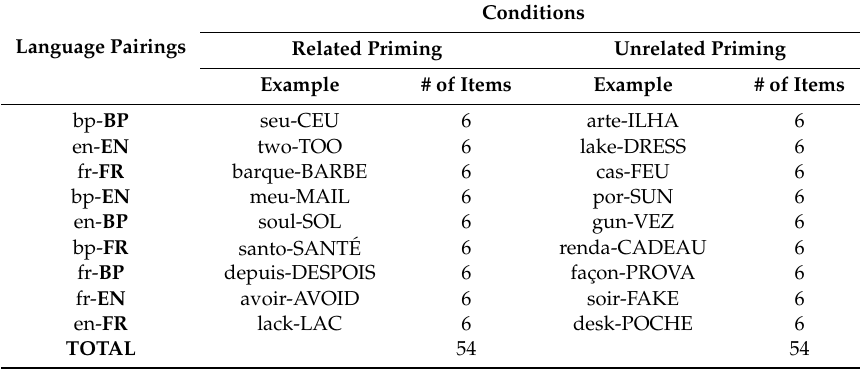
Table 2. Each sub-condition involved six word pairs: three sets of monosyllabic words and three sets of disyllabic words. All of them were high-frequency words, as per the corpora from which they were taken ( Ceten-Folha for Portuguese, Lexique for French, and Brown for English). All the words used are provided in Appendix A. Table 2. Summary of language pairings and conditions devised for the grapho(-phonic)-phonologically primed task.